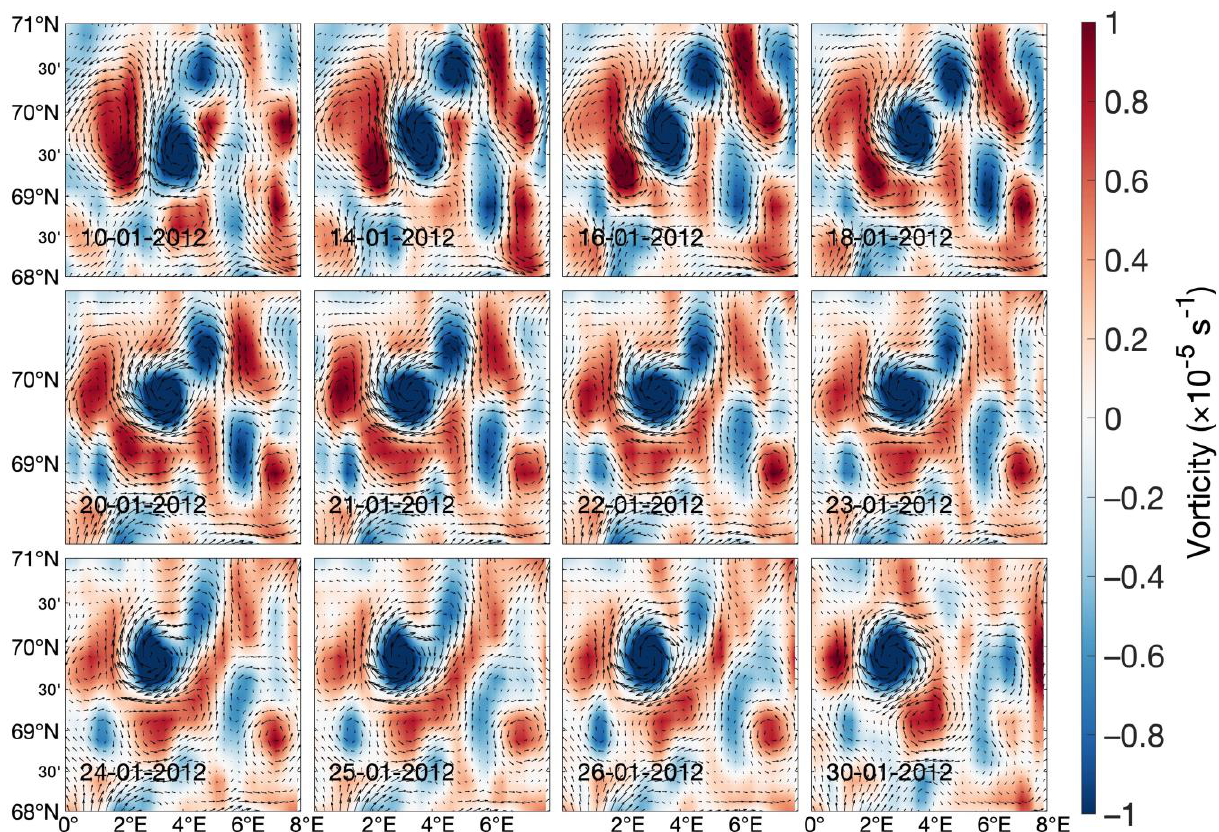
Figure 5. Merging evolution of the LV and OAE. The vorticity fields and geostrophic currents from 10-01-2012 to 30-01-2012 are